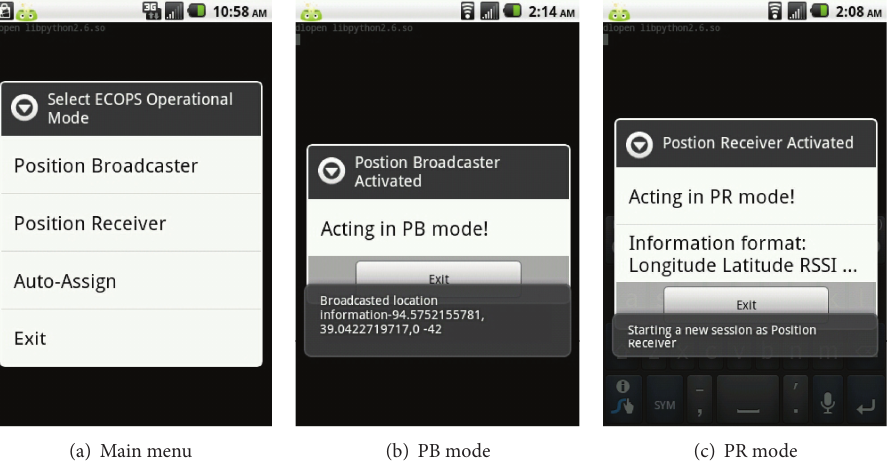
Figure 7: ECOPS screenshots.